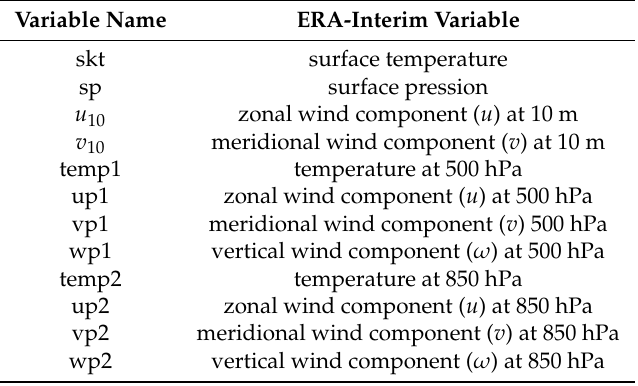
Table 2. Predictive variables considered at each node from the ERA-Interim